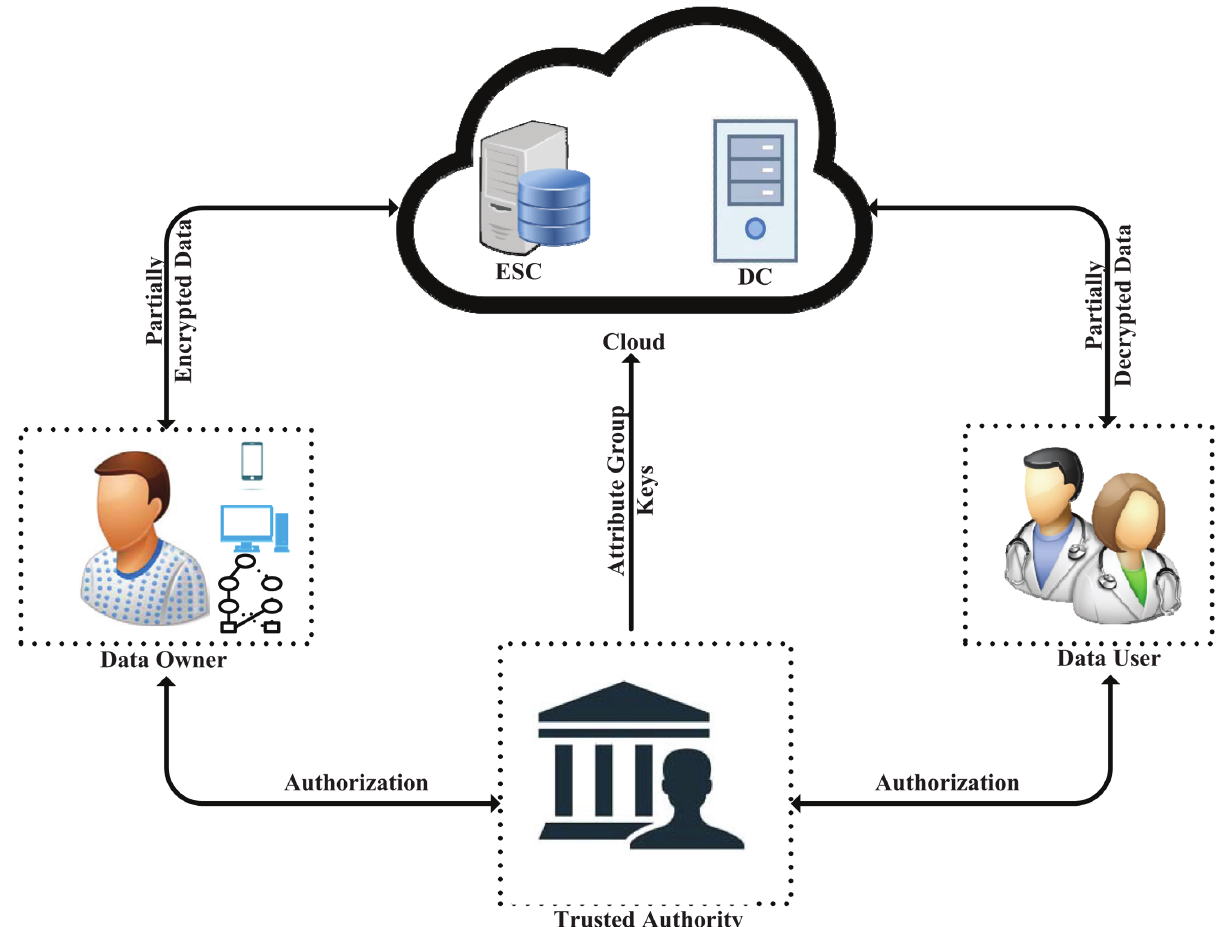
Fig 2. An architecture of our scheme depicting the entities